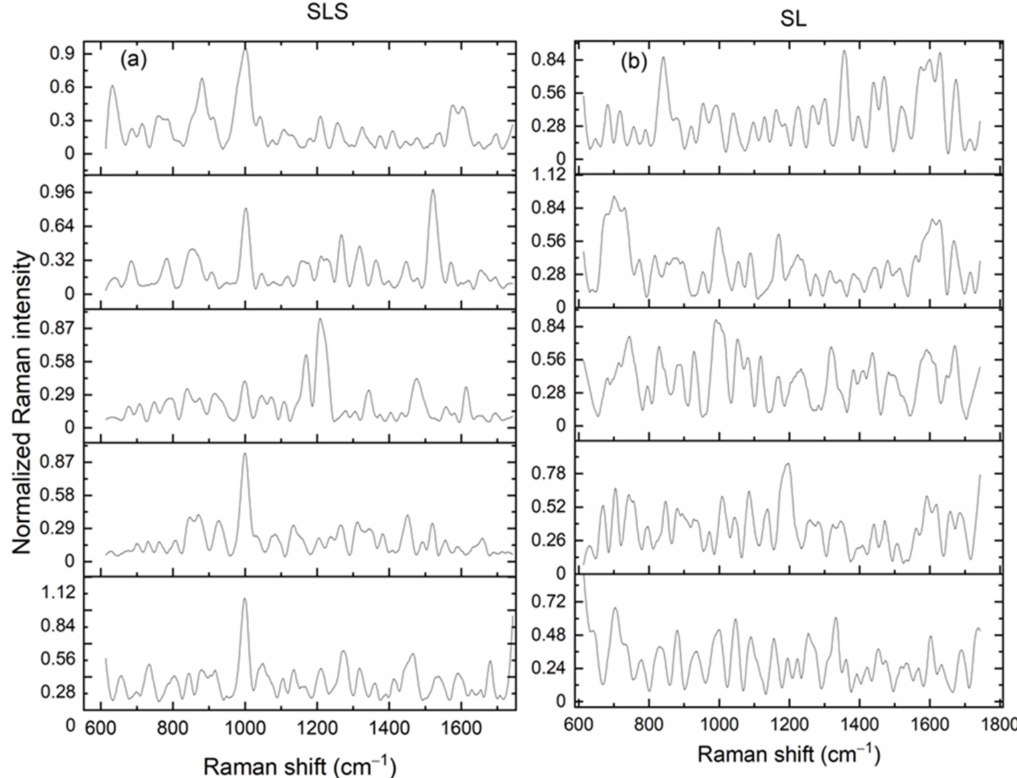
Figure 6. SERS spectra of ( a ) SLS and ( b ) SL on different positions after smoothing, subtraction, and normalization. Acquisition time 3 s, wavelength 632.8 nm, power 50 microwatt. SERS spectra are recorded on the same substrate; each spectrum is the result of an average of three spectra taken from three positions. The raw data are presented in the Supplementary Materials (see Figure